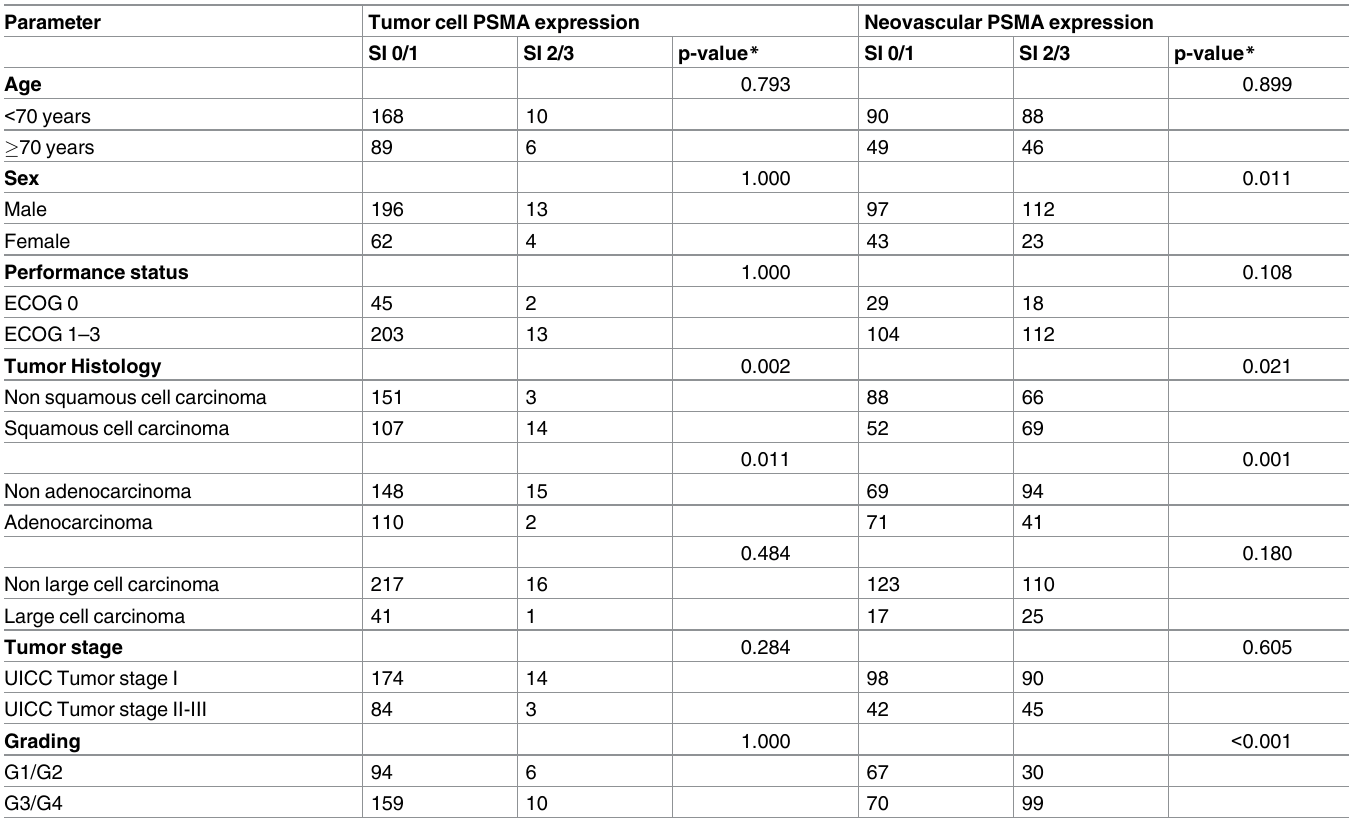
Table 2. Correlations of clinicopathological variables with PSMA in NSCLC